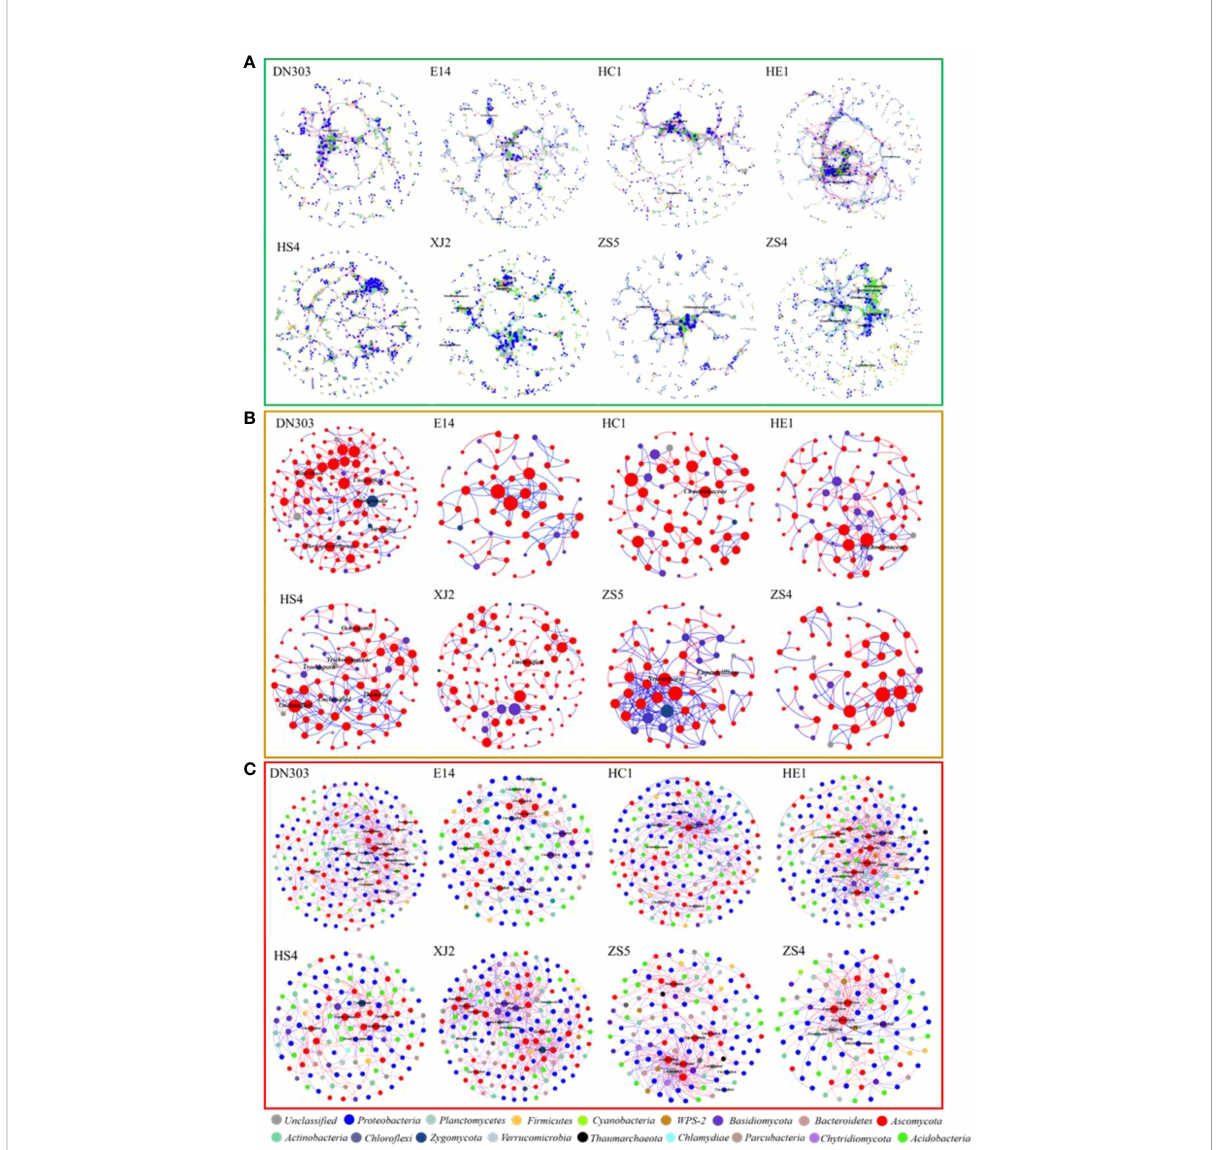
FIGURE 1 Intra- and inter- domain networks of bacterial and fungal and bacterial-fungal communities. The size of the node represents the node degree of the OTUs (The number of connections among OTUs). Node color represents taxonomic groups within each network. Lines connecting nodes (edges) represented positive (red) and negative (green) interactions. Those nodes with a label at genus level were core taxa of the network (connectors, module hubs and network hubs). (A) The intra-domain networks of the bacterial community. (B) The intra-domain networks of fungal community. (C) The inter-domain networks of bacterial-fungal community. Dongnong303 (DN303), E14(E14), Huacai1 (HC1), Huaen1 (HE1), Huashu4 (HS4), Xingjia2 (XJ2), Zhongshu5 (ZS5) and Zhongshu4 (ZS4) were planted under continuous cropping regime. The networks were visualized using Gephi 0.9.2